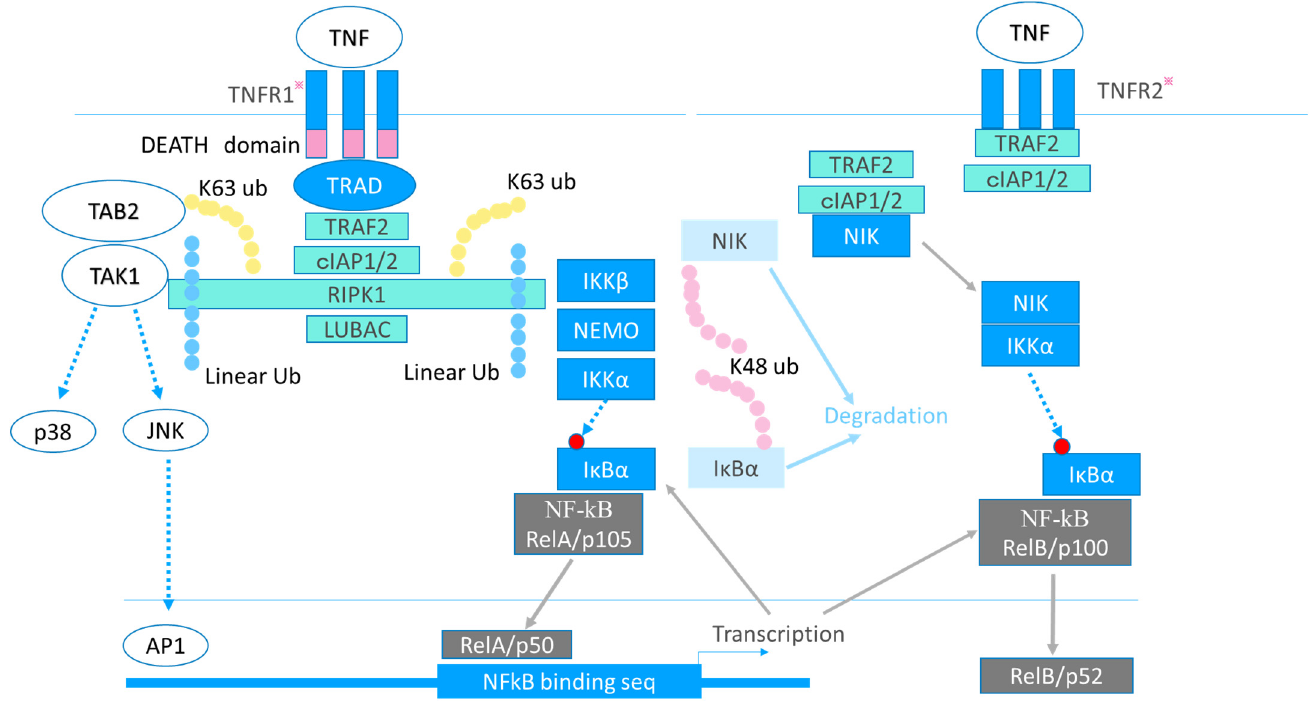
Figure 2. Signaling cascade of TNF. The tumor necrosis factor (TNF) receptor (TNFR)1 possesses the intracellular DEATH domain, which regulates apoptosis through activation of caspases, whereas TNRF2 does not. TNFR1 recruits the adaptor protein, TNF receptor-associated death domain (TRADD), through its DEATH domain. Activated TNFR1 recruits TRADD, TNF receptor-associated factor 2 (TRAF2), receptor-interacting protein kinase 1 (RIPK1), and cell inhibitor of apoptosis protein-1/2 (cIAP1/2) to form Complex I. Complex 1 activates NF-kB and